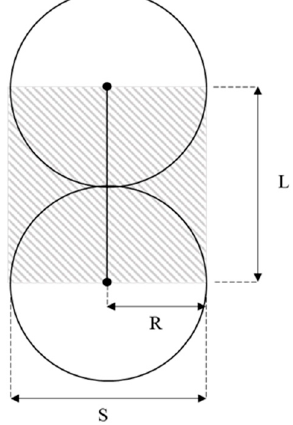
Figure 3. Basic Mechanical Unit of SCC Ball Array.